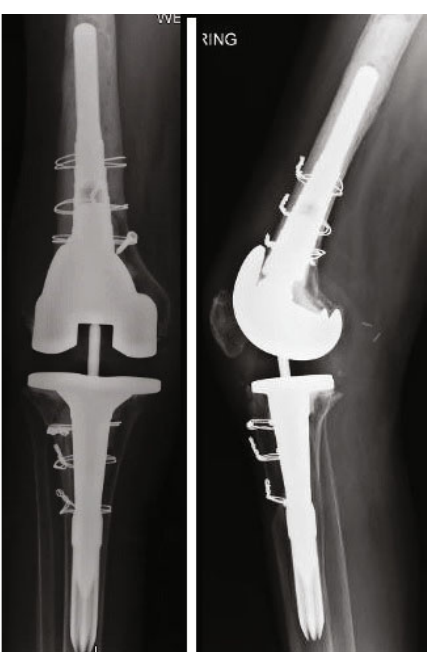
Figure 8: Postop after the second stage of the TKA